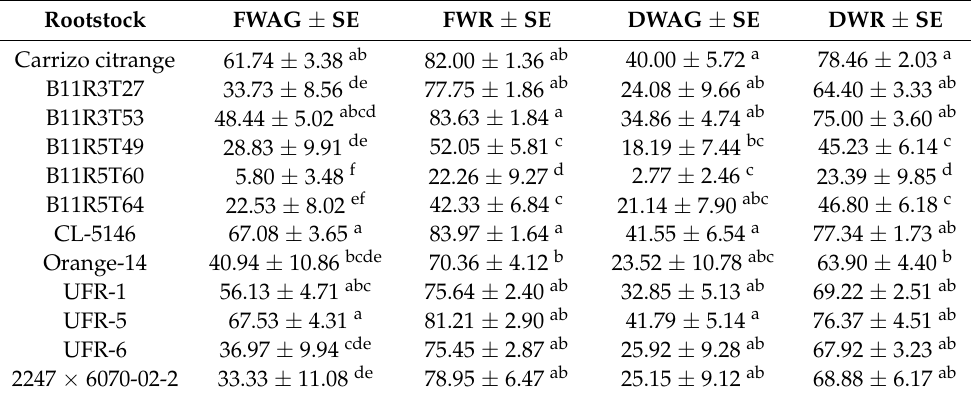
Table 3. Mean Percentage of biomass reduction (%) ± standard error (SE) of fresh (FW) and dry weight (DW) on above ground sections (AG; leaves + stems) and root sections (R), due to the effect of R. necatrix , in 12 citrus rootstocks (Carrizo citrange, B11R3T27, B11R3T53, B11R5T49, B11R5T60, B11R5T64, CL-5146, Orange-14, UFR-1, UFR-5, UFR-6 and 2247 × 6070-02-2). Rootstock FWAG ± SE FWR ± SE DWAG ± SE DWR ± SE Carrizo citrange